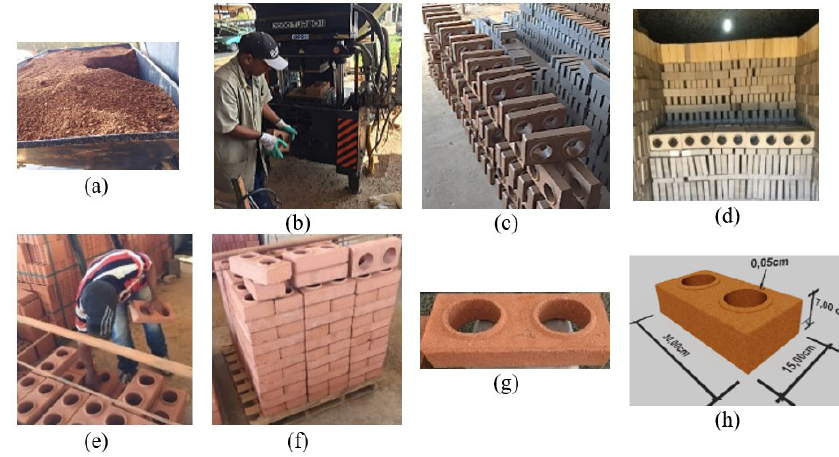
Figure 1. Manufacturing of the pressed and burned blocks: ( a , b ) manufacturing steps; ( c ) drying; ( d ) burn; ( e , f ) storage; ( g , h ) description of the block.